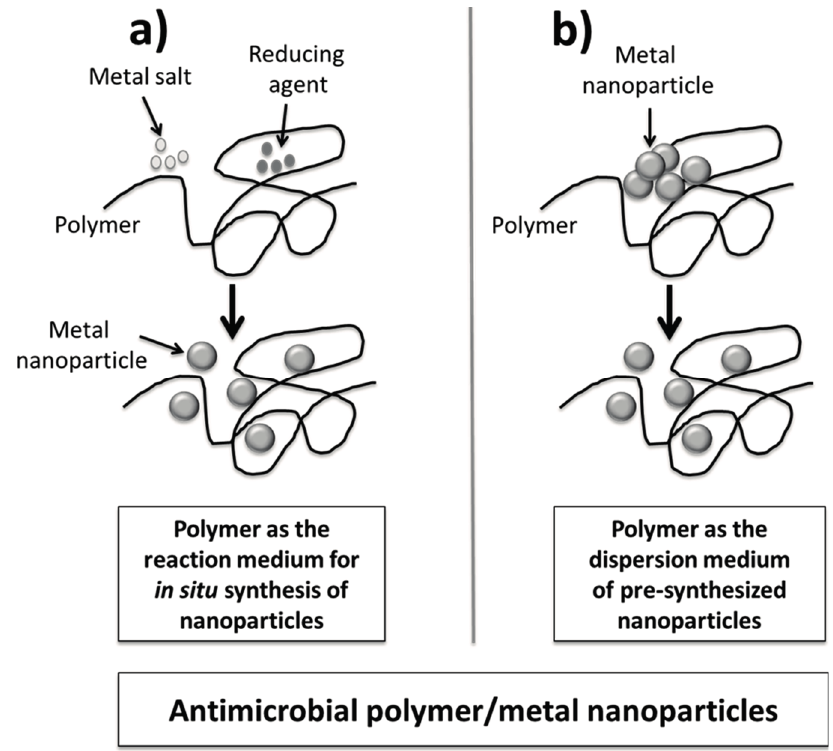
Figure 3. Two main routes producing antimicrobial polymer/metal nanocomposites: ( a ) Polymer as reaction mediun for in-situ synthesis of nanoparticles; and ( b ) Polymer as a dispersion mediun of pre-synthesized